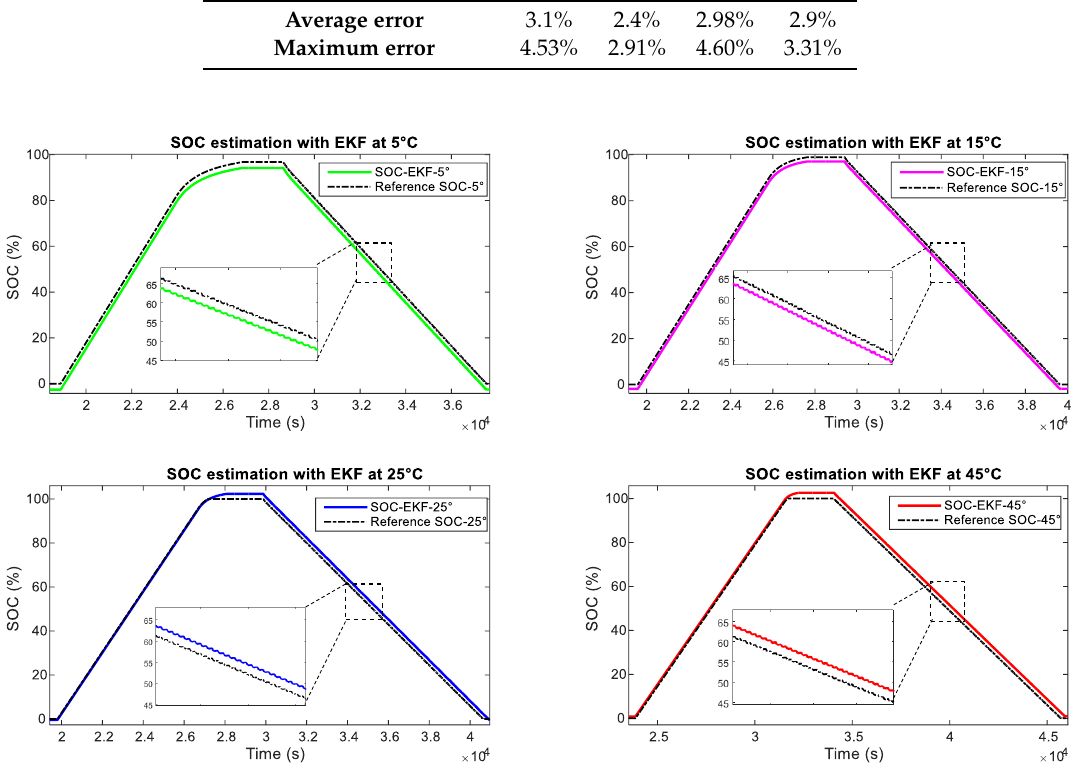
Figure 18. EKF estimation using the proposed OCV model at different temperatures.